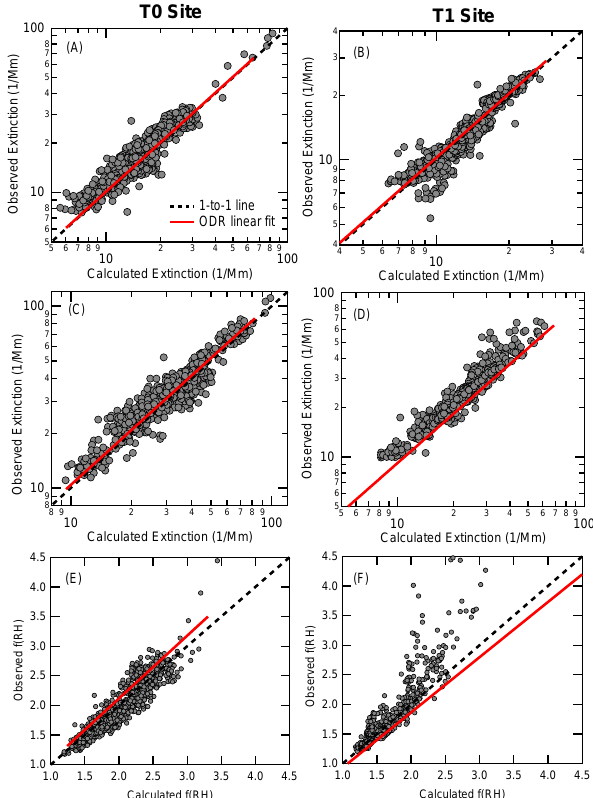
Figure 4. Scatter plot comparisons between observed and calcu- lated b ext or b scat for low RH ( a and b ) and high RH ( c and d ) and f (RH) ( e and f ) values at the T0 site (left panels) and the T1 site (right panels). The red and dashed lines represent the best ODR linear fit to the data and the 1:1 line, respectively. For T0, calcu- lated b ext,low and b ext,high values are excluded during the period over which synthetic supermicron size distributions were